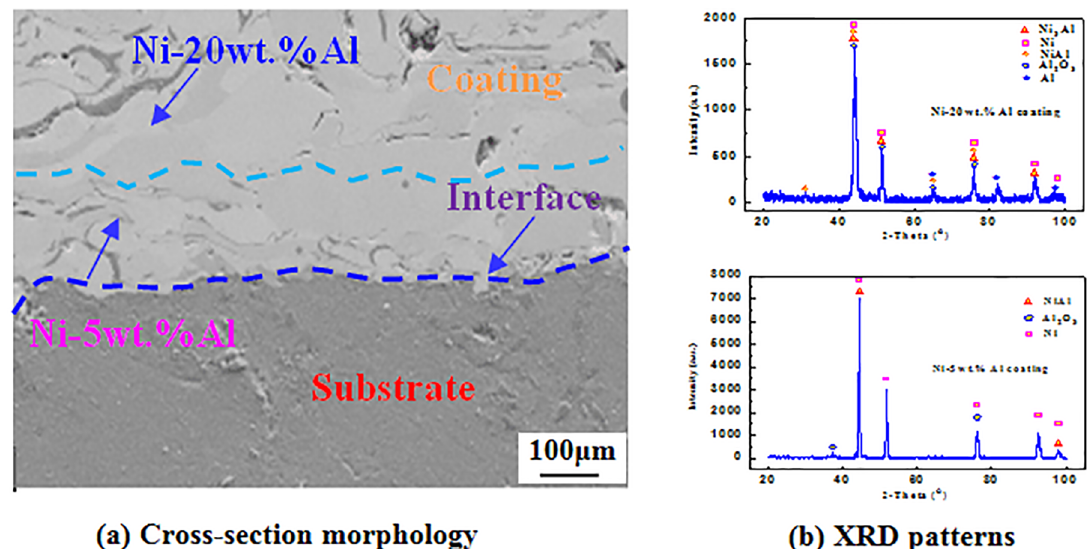
Figure 15. Cross-section morphology (a) and XRD patterns of Ni-20wt.%Al and Ni-5wt.%Al coatings